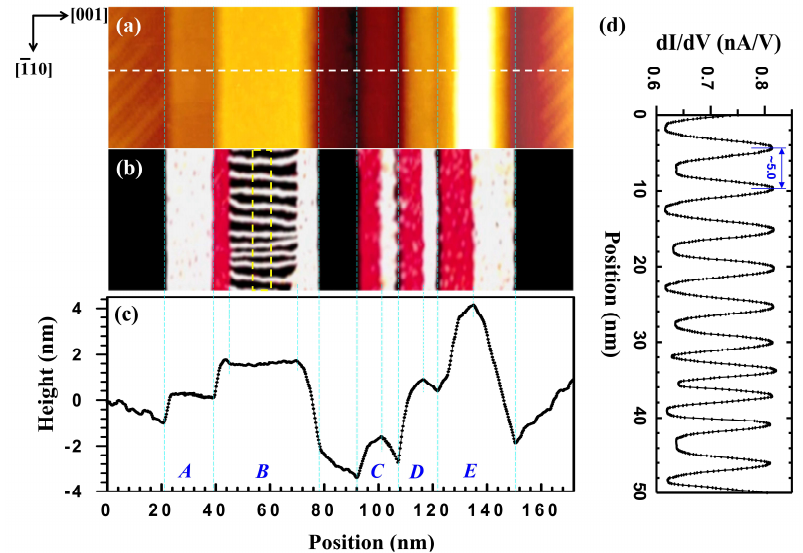
Figure 3. ( a ) SP-STM image (172 × 50 nm 2 ) of parallel Fe-silicide NWs on the Si(110) surface. ( b ) SP- d I / d V map at + 0.50 V acquired simultaneously with ( a ). ( c ) Cross-sectional profiles across the parallel Fe-silicide NWs along the white dashed line indicated in ( a ). ( d ) The magnetic d I / d V profile averaged over the green box in ( b ). The magnetization modulation in NW B shows a magnetic period of ~5 nm. The crystal directions are indicated in the figures.